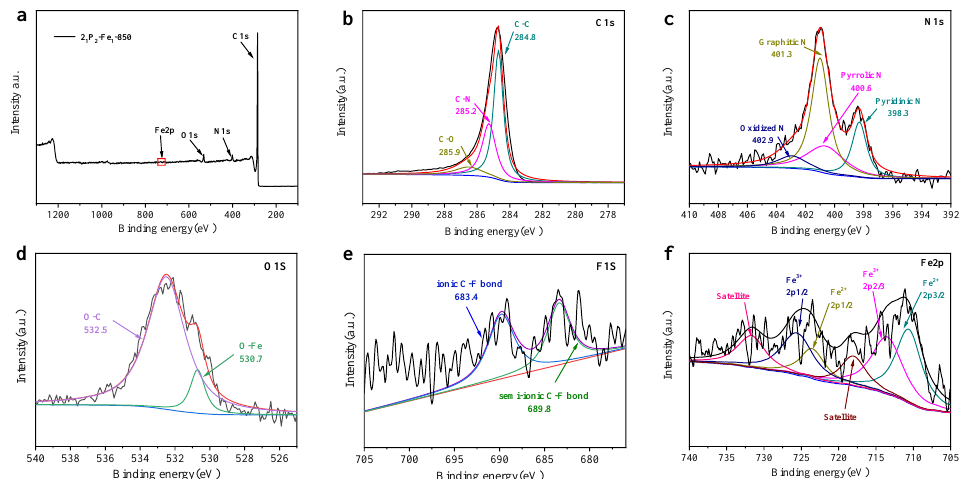
Figure 7. XPS measurement spectra of 2 1 P 2 -Fe 1 -850: ( a ) total XPS measurement spectrum; ( b ) C1s, ( c ) N1s, ( d ) O1s, ( e ) F1s, and ( f ) Fe2p high-resolution spectra.